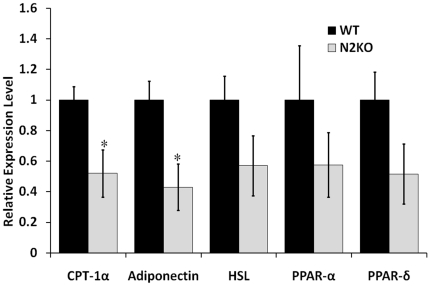
WAT metabolic gene expression profile in WT and N2KO mice.Relative quantitative expression levels of carnitine palmitoyltransferase-1α (CPT-1α), adiponectin, hormone sensitive lipase (HSL), and peroxisome proliferator-activated receptor alpha (PPARα) and delta (PPARδ) in WAT from ad lib fed WT and N2KO. All samples were normalized to β-actin expression. The data is reported as the mean expression level relative to WT expression ± SEM. (*p≤0.05, **p≤0.01).